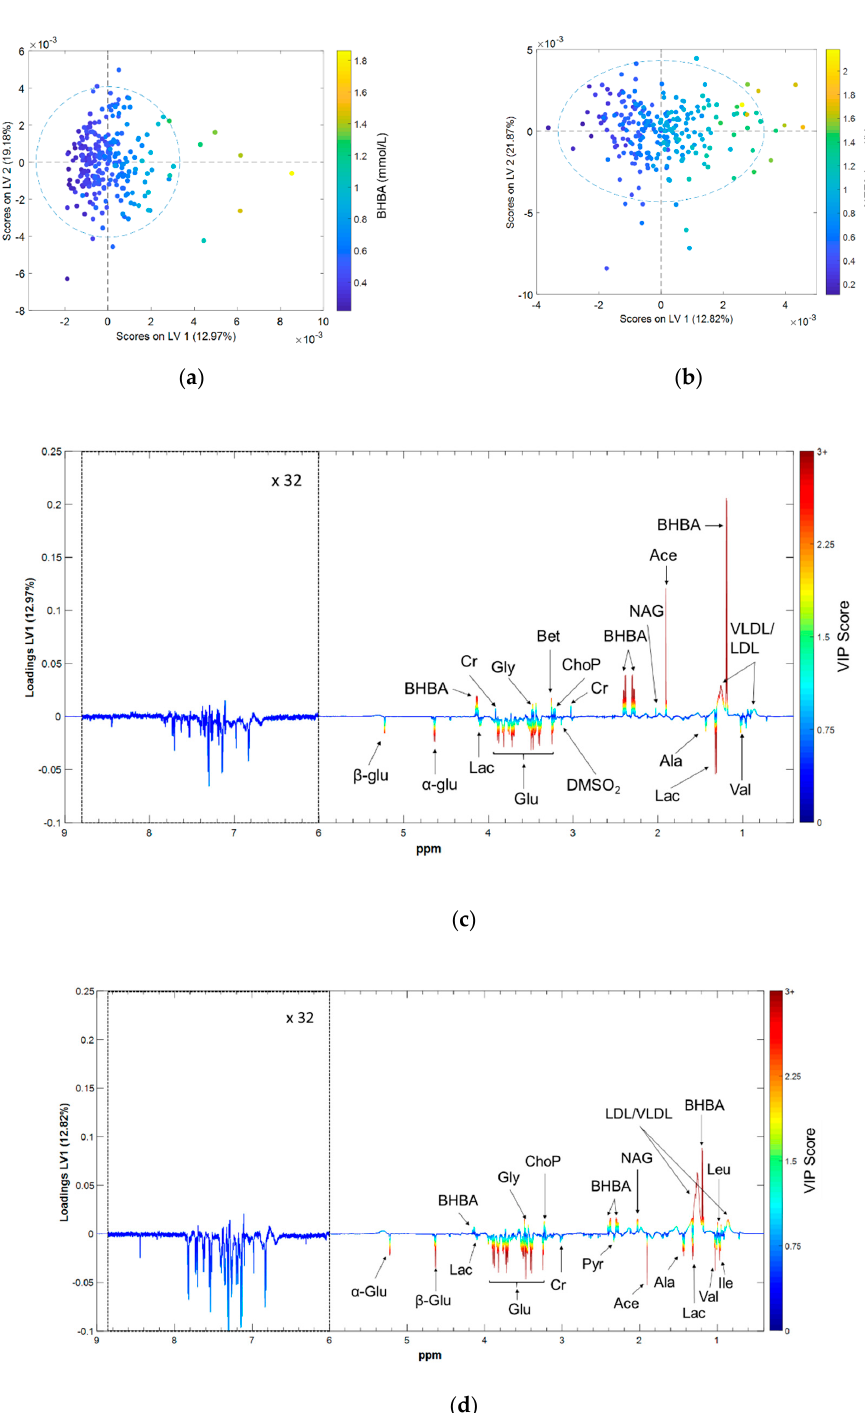
Figure 3. Results of the orthogonal partial least squares (OPLS) regression models predicting serum BHBA and NEFA concentrations from 1 H NMR spectra; ( a ) First latent variable (LV1) vs. second latent variable (LV2) scores for the BHBA prediction model; ( b ) LV1 vs. LV2 scores for the NEFA prediction model; ( c ) LV1 loadings for the BHBA prediction model; ( d ) LV1 loadings for the NEFA prediction model. Scores plots color-coded by reference biomarker concentration, loadings plots by VIP score. α -Glu = α glucose, β -Glu = β glucose, Ace = acetate, Ala = alanine, Bet = betaine, BHBA = β hydroxybutyrate, Cr = creatine, DMSO 2 = dimethyl sulfone, Glu = glucose, Gly = glycine, Ile = isoleucine, Lac = lactate, Leu = leucine, NAG = N-acetyl glycoprotein, ChoP = phosphocholine, Pyr = pyruvate, Val = valine, LDL = low density lipoprotein; VLDL = very low density